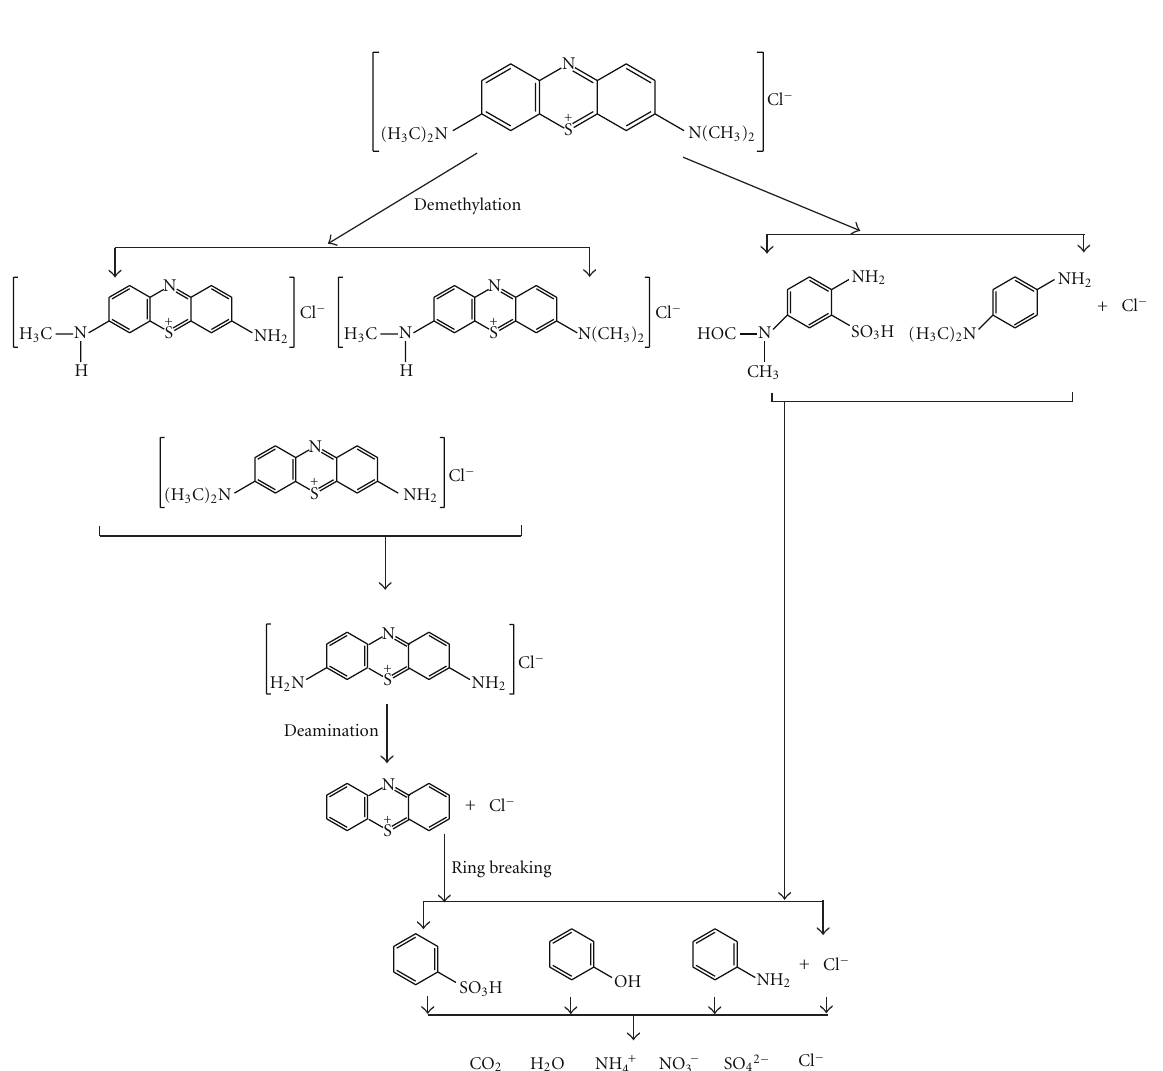
Figure 9: Suggested photocatalytic degradation pathway scheme for methylene blue under visible light irradiation in the presence of Fe 2 BiSbO 7